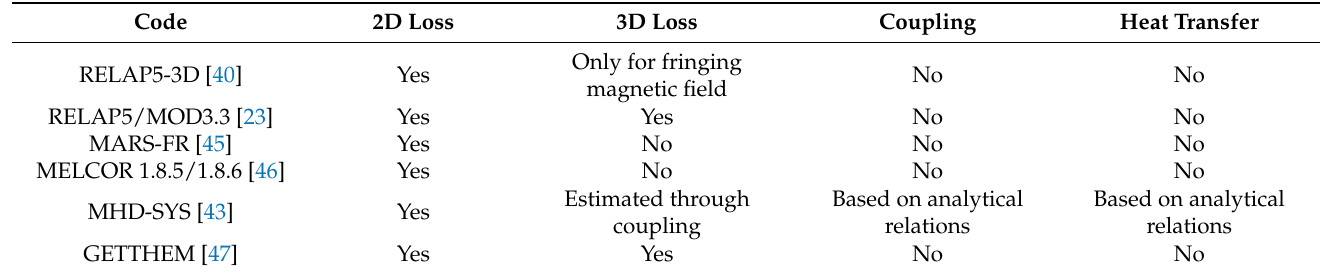
Table 1. SYS-TH capabilities for MHD